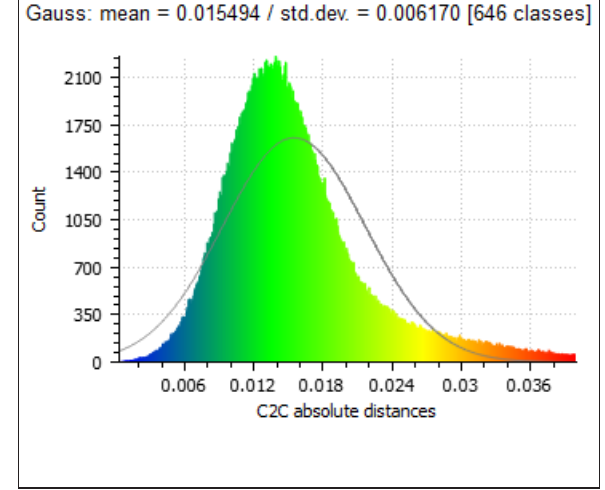
Figure 24. TIMMS/FARO histogram